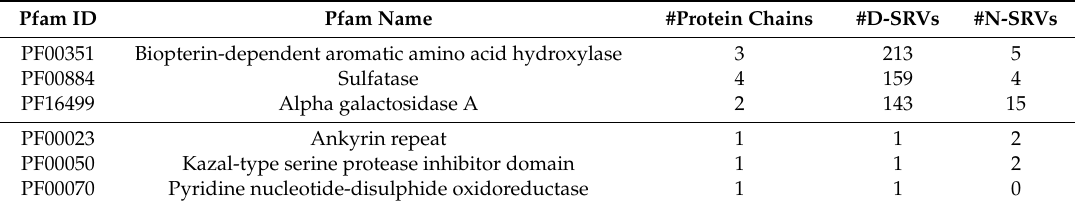
Table 5. Pfam domains in HVAR3D. The highest and the lowest represented Pfam domains in terms of number of variations are reported in the first and last three rows,